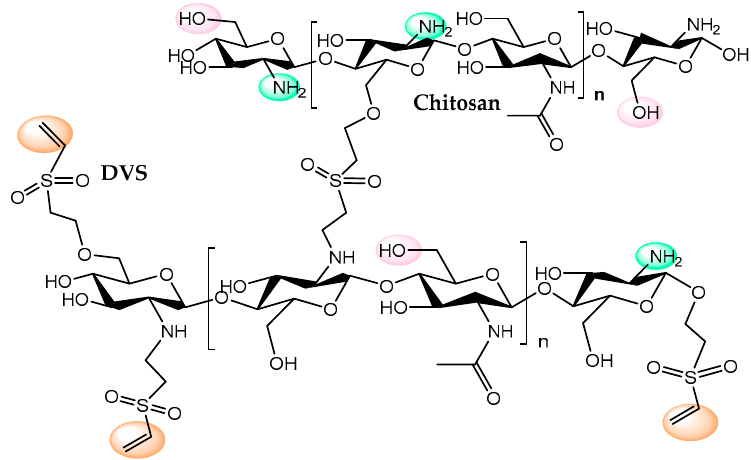
Figure 9. Schematic representation of the crosslinking reaction of chitosan with divinyl sulfone and the different functional groups on the activated chitosan surface.